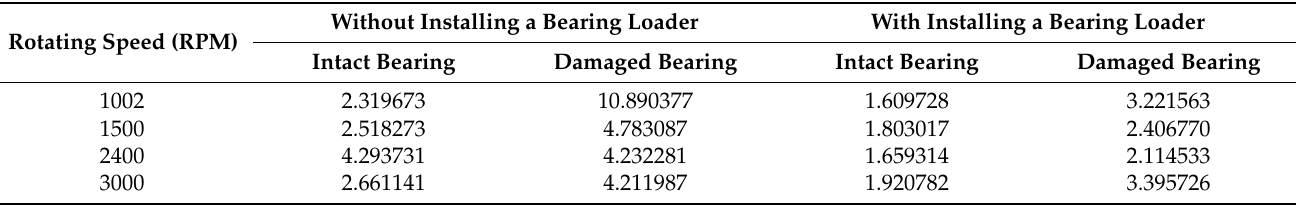
Table 4. Averaged kurtosis values for an inner race defect.